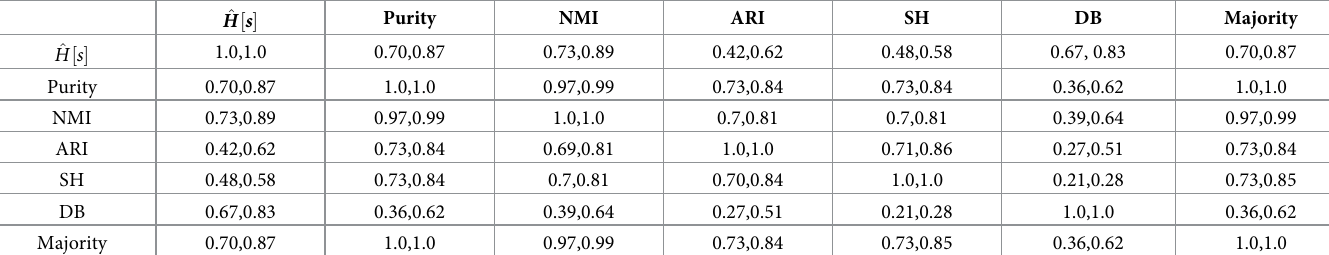
Table 15. Kendall’s τ and Spearman’s correlation result for Synthetic.